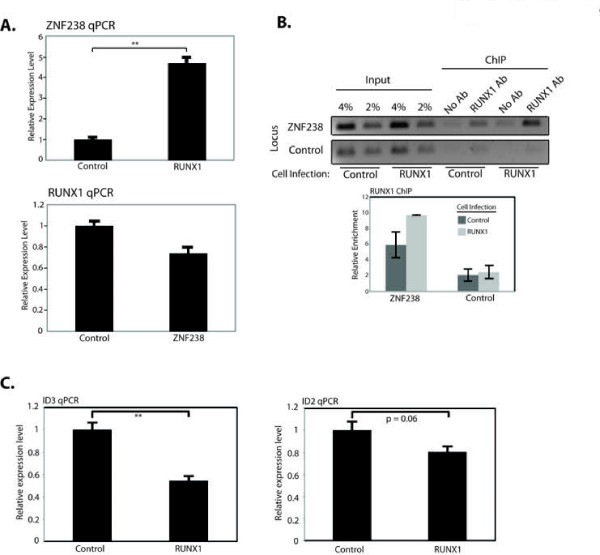
ZNF238 is a downstream target of MyoD and RUNX1. (A) qPCR for RUNX1 and ZNF238 in RD cells transduced with virus expressing the converse factor. (B) RUNX1 ChIP results at the intron of ZNF238 and a control locus before (Control) and after (RUNX1) infection of the cells with empty or RUNX1-expressing retrovirus. (C) qPCR for ID genes in control and RUNX1-expressing RD cells. PCRs in the imaged gel in 3B were performed for the same number of cycles. The graph in 3B represents qPCR data showing the mean ± SEM of two independent experiments. Relative enrichment is calculated as the ratio of the % of input amplified with antibody to the % of input amplified with no antibody. qPCRs in 3A and 3C are represented as the mean ± SEM of at least three independent experiments. *: P < 0.05; **: P < 0.01.